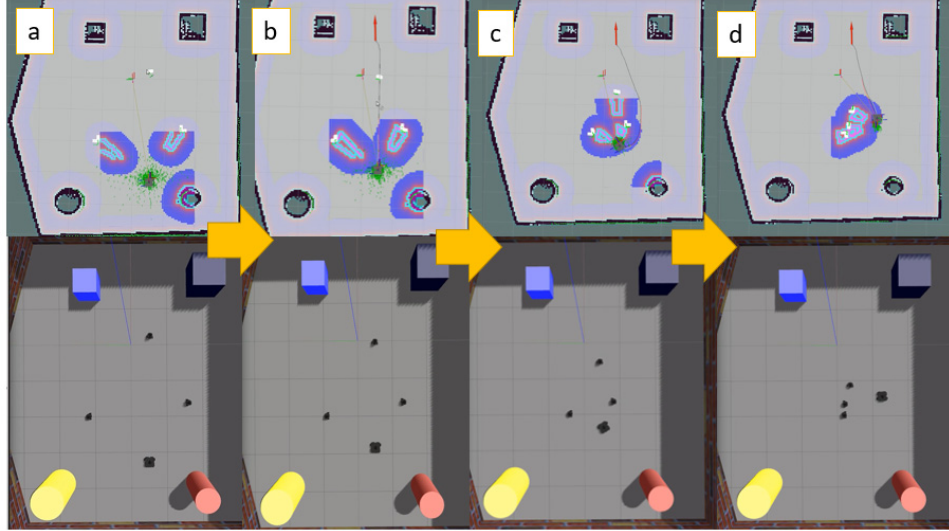
Figure 16. Multi-dynamic obstacle avoidance simulation: ( a ) three dynamic obstacles approach the robot in high seed, ( b ) the robot is expected to collide with dynamic obstacle via VO, ( c ) the robot updates a new path to avoid all dynamic obstacles, ( d ) the robot has succeeded at avoiding all dynamic obstacles.